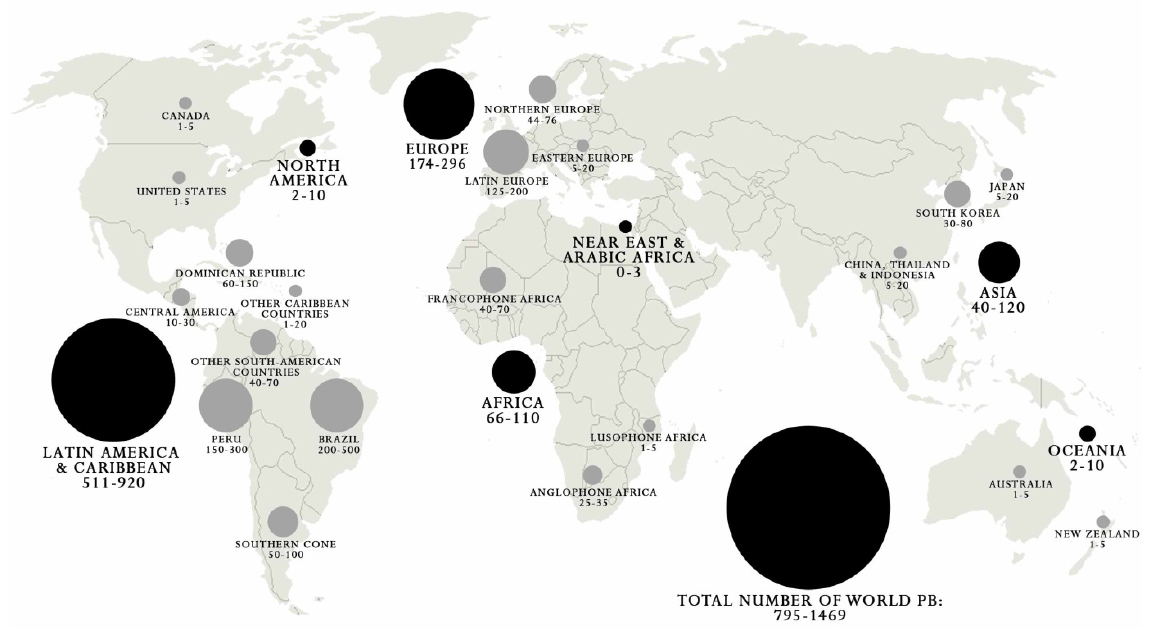
Figure 1: Participatory budgeting across the world